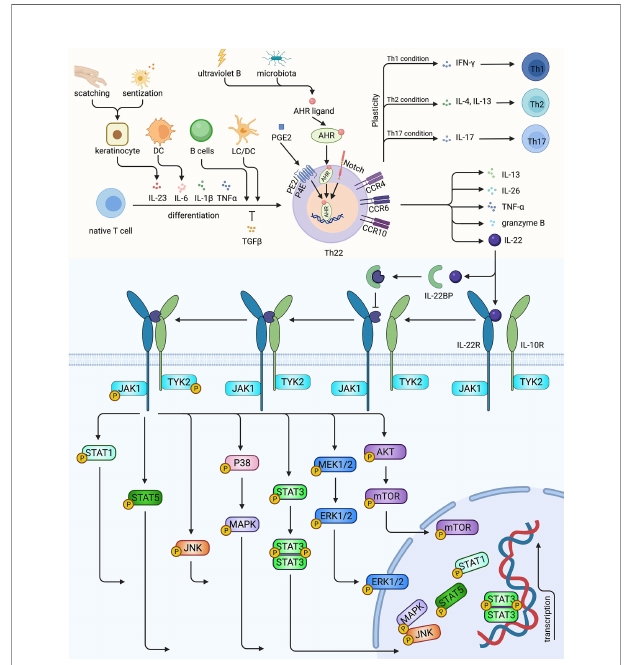
FIGURE 1 | The characterization, differentiation of Th22 and the signaling pathway of Th22/IL-22. Native T cells induced by IL-6, IL-23, IL-1 b and TNF- a , mediated by LC, DC or activated B cells could differentiate into Th22, while TGF b could inhibit Th22 polarization. AHR, the master transcription factor of Th22, could be upregulated by ultraviolet B, microbiota, PGE2 and Notch signaling. Th22 secreted its effector cytokine IL-22, as well as IL-13, IL-26, TNF- a and granzyme B. Th22 might converted to Th1, Th2, Th17 under certain conditions. IL-22 could bind to receptor complex of IL-22R and IL- 10R, activating TYK2 and JAK1, thus mediating multiple pathways. In contrast, the decoy receptor IL-22BP blocks the roles of IL-22. Th22, T helper 22 cell; LC, Langerhans cell; DC, dendritic cell; AHR, aryl hydrocarbon receptor; IL-22R, IL-22 receptor; IL-10R, IL-10 receptor; IL-22BP, IL-22 binding protein; PGE2, Prostaglandin E2. Created with